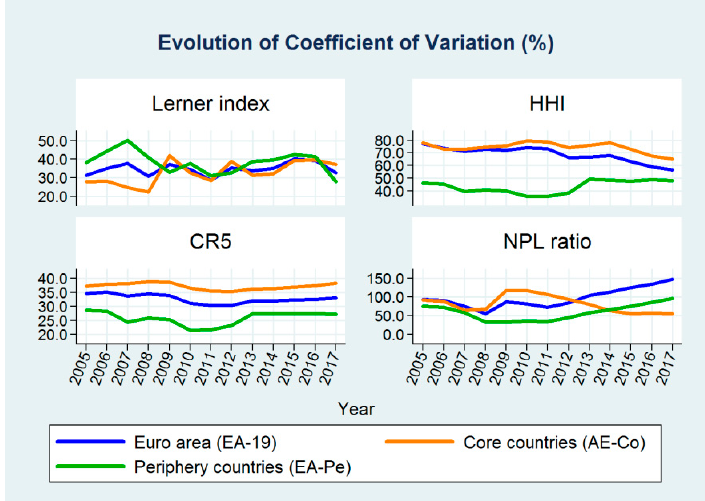
Figure 2. Evolution of the Coefficient of Variation (%). Source: BankScope database, European Central Bank (ECB), World Bank, own calculations.